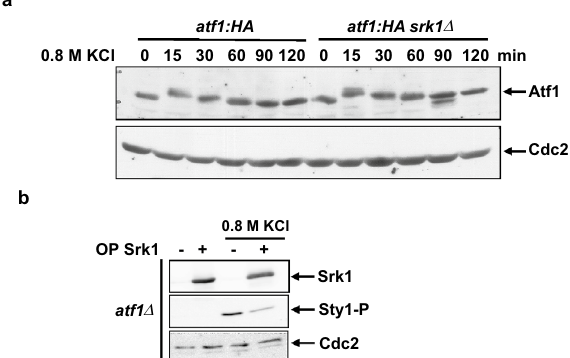
Figure 3. Atf1 response to stress is independent of Srk1. ( a ) Total extracts from growing cultures of wild- type and srk1∆ cells expressing genomic atf1:HA6his were untreated (0 min) or treated with 0.8 M KCl at the indicated times and resolved in SDS-PAGE. Total Atf1 protein was detected with anti-HA antibody. ( b ) atf1 deleted cells with (+) or without (−) Srk1 overexpression (OP Srk1: through the inducible plasmid pREP1- srk1:HA6his ) for 20 h were untreated or treated with 0.8 M KCl for 15 min. Activated (Sty1-P) and total Sty1 were detected with anti-phospho p38 and anti-HOG1 antibodies, respectively. The level of overexpressed